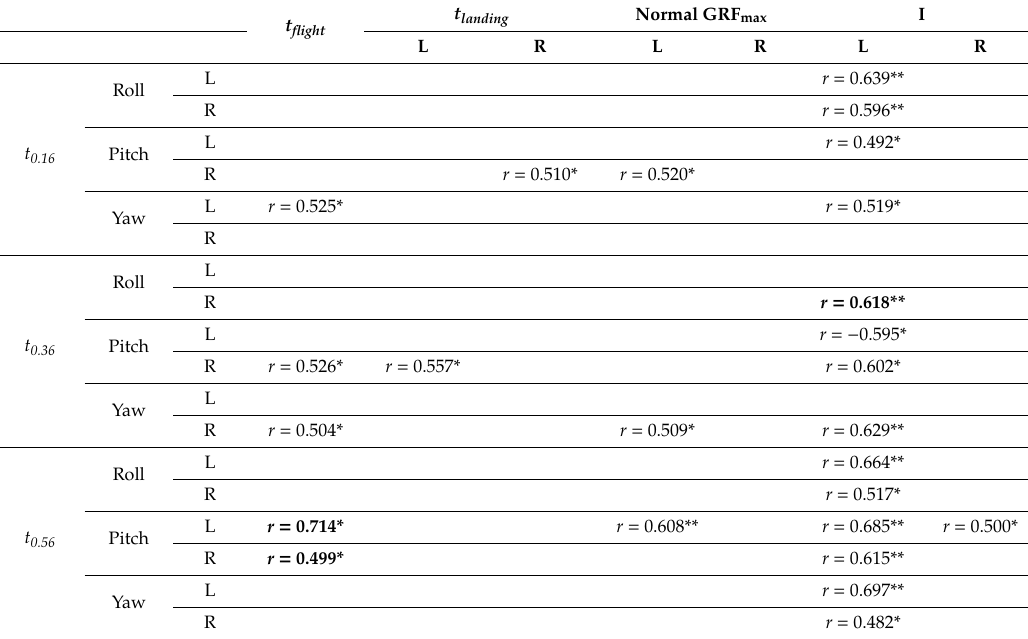
Table 2. Correlations between t f light , t landing , normal GRF max , and impulse I acting on the left (L) and right (R) foot, and the ski roll, pitch, and yaw ROM of the L and R side at t 0.16 , t 0.36 , t 0.56 , t 0.76 ,